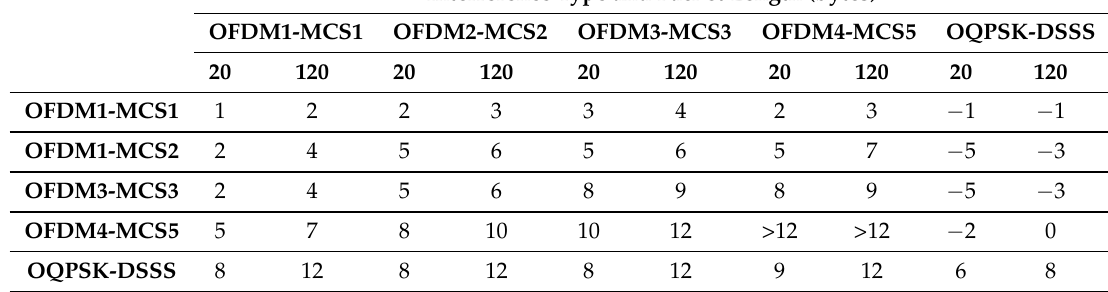
Table 4. Results summary. Each value in the table is the required SIR (dB) to ensure a PDR > 80% for each modulation (OFDM1-MCS1, OFDM2-MCS2, OFDM3-MCS3, OFDM4-MCS5, OQPSK-DSSS) and packet length (20, 120